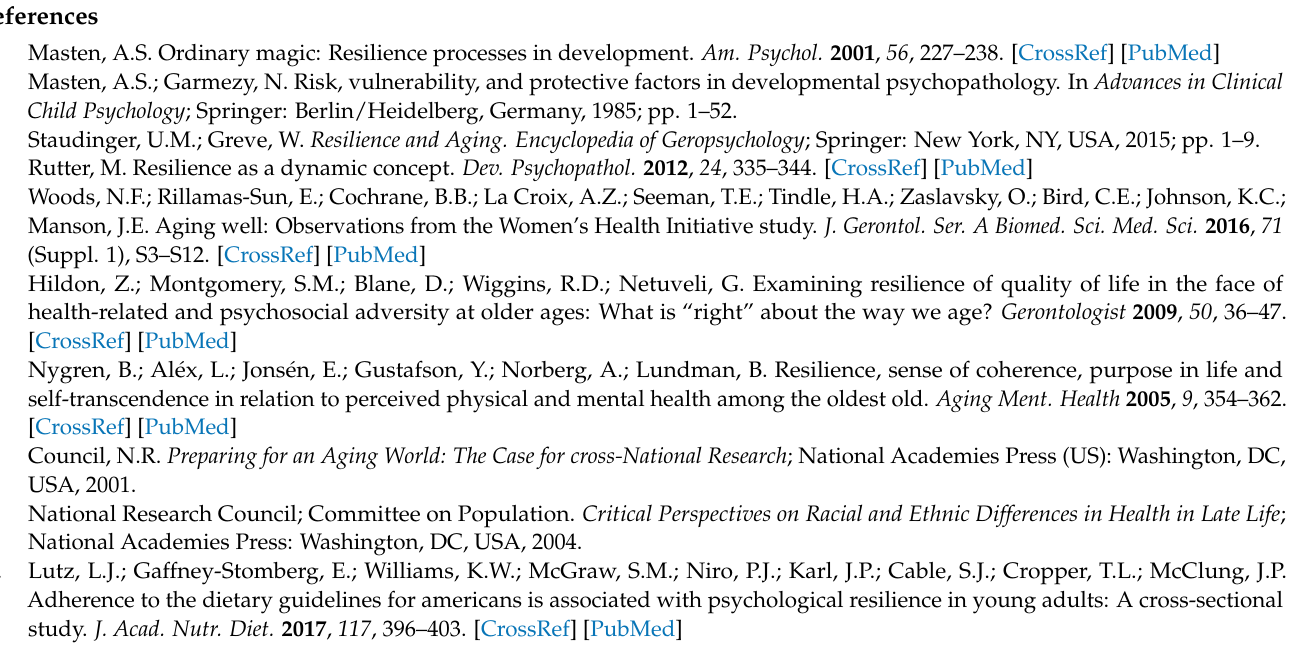
Table S2a: Ranking of variable importance in Elastic Net model using all variables (Top 10 variables from Model E1 shown); Table S2b: Ranking of variable importance in Elastic Net model using only non-psychological variables (Top 5 variables from Model E2 shown); Table S2c Ranking of variable importance in Elastic Net model using only psychological variables (Top 5 variables from Model E3 shown); Table S3: Estimated associations between self-reported psychological resilience, energy score, and control of beliefs with race/ethnicity